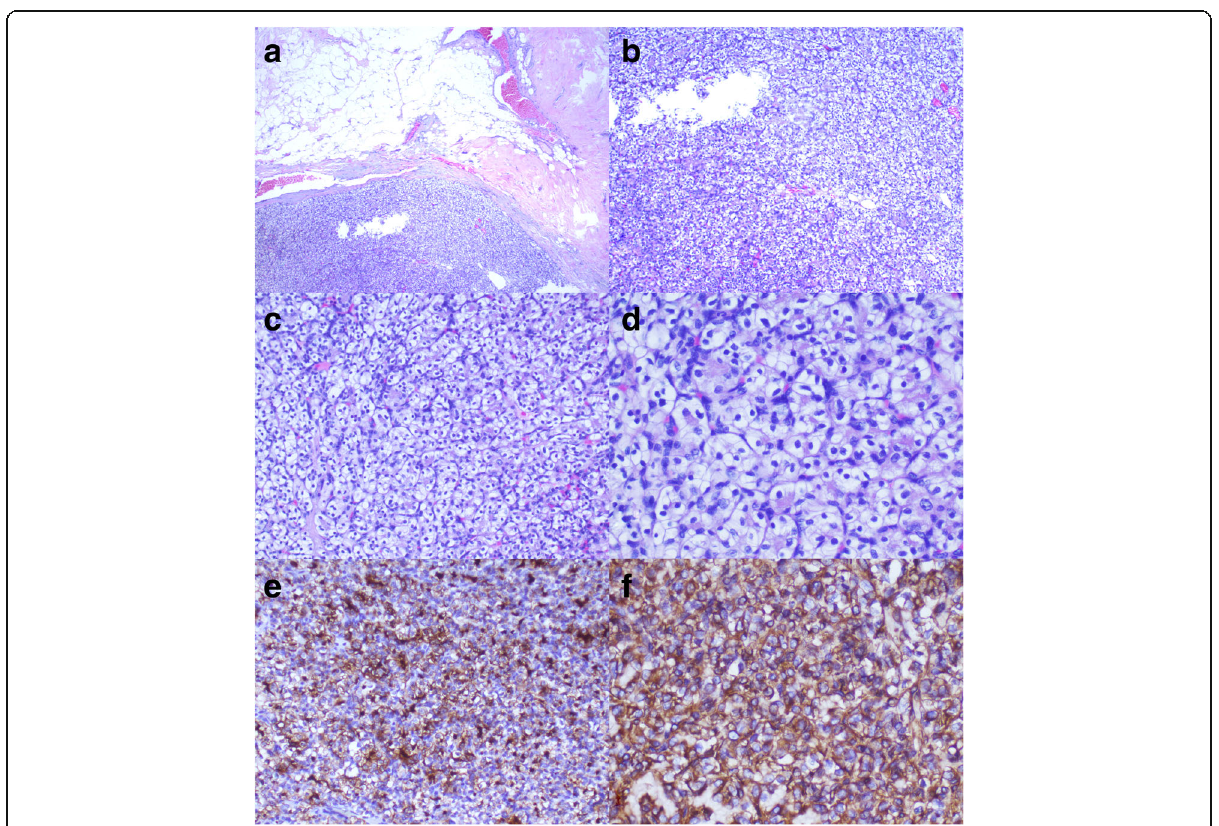
Fig. 3 Renal clear cell carcinoma metastasis to the breast. a A low-power view showed a metastatic clear cell RCC in the breast with atrophic breast parenchyma in the background. The apparent circumscription and the pseudocapsule surrounding the carcinoma were noted (black arrows), (hematoxylin-eosin, original magnification 40×). b A medium-power view showed infiltration of clear cells into the surrounding breast tissue (hematoxylin-eosin, original magnification 100×). c Clear cells with distinct cytoplasmic borders were arranged in nests separated by a thin fibrovascular stroma (hematoxylin-eosin, original magnification 200×). d A high-power view revealed foamy, vacuolar cytoplasm and large nucleoli consistent with clear cell RCC (hematoxylin-eosin, original magnification 400×). e Renal neoplastic cell showing strong membranous staining with CD10 (immunohistochemistry, original magnification 400×). f Diffuse and strong cell cytoplasm staining for vimentin was observed in clear cell RCC. Positive cells displayed brownish yellow granules on the surface, cytoplasm, and intercalated discs (immunohistochemistry, original magnification